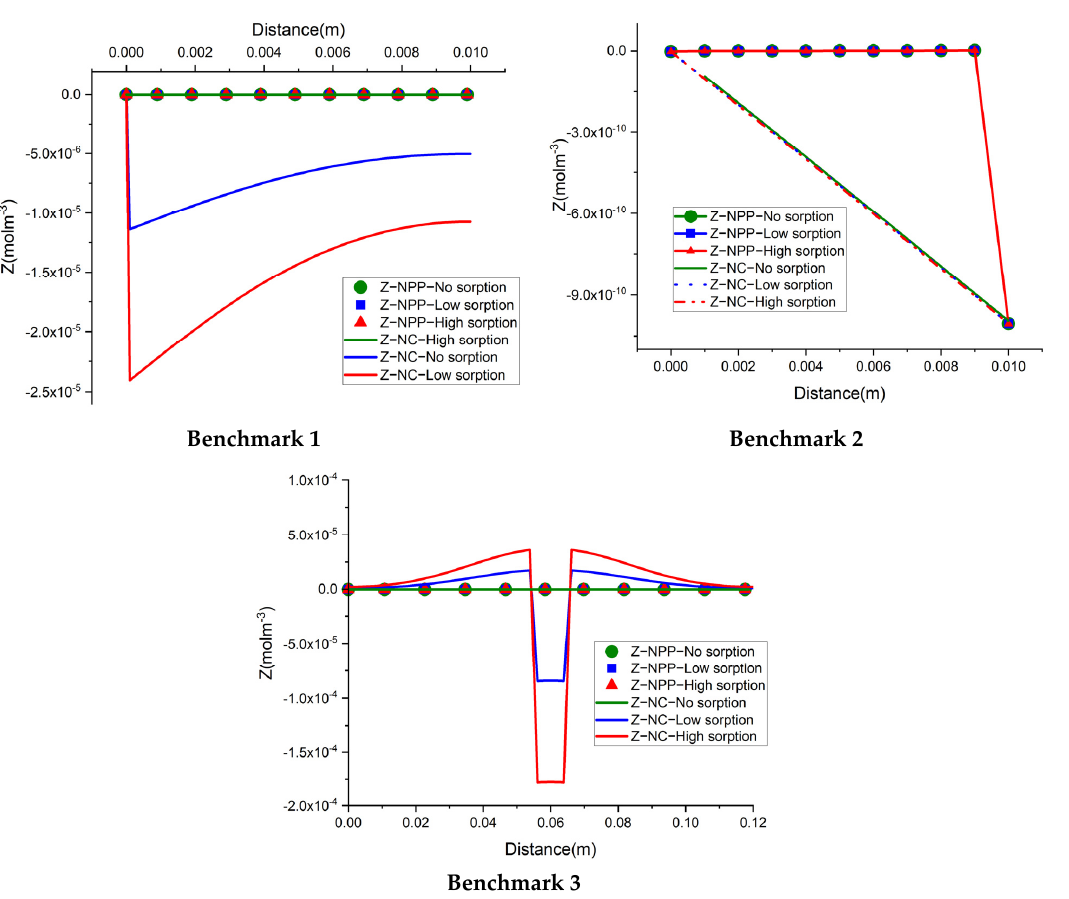
Figure 8. The total charge for the 1D benchmarks with the NPP and NC-models.